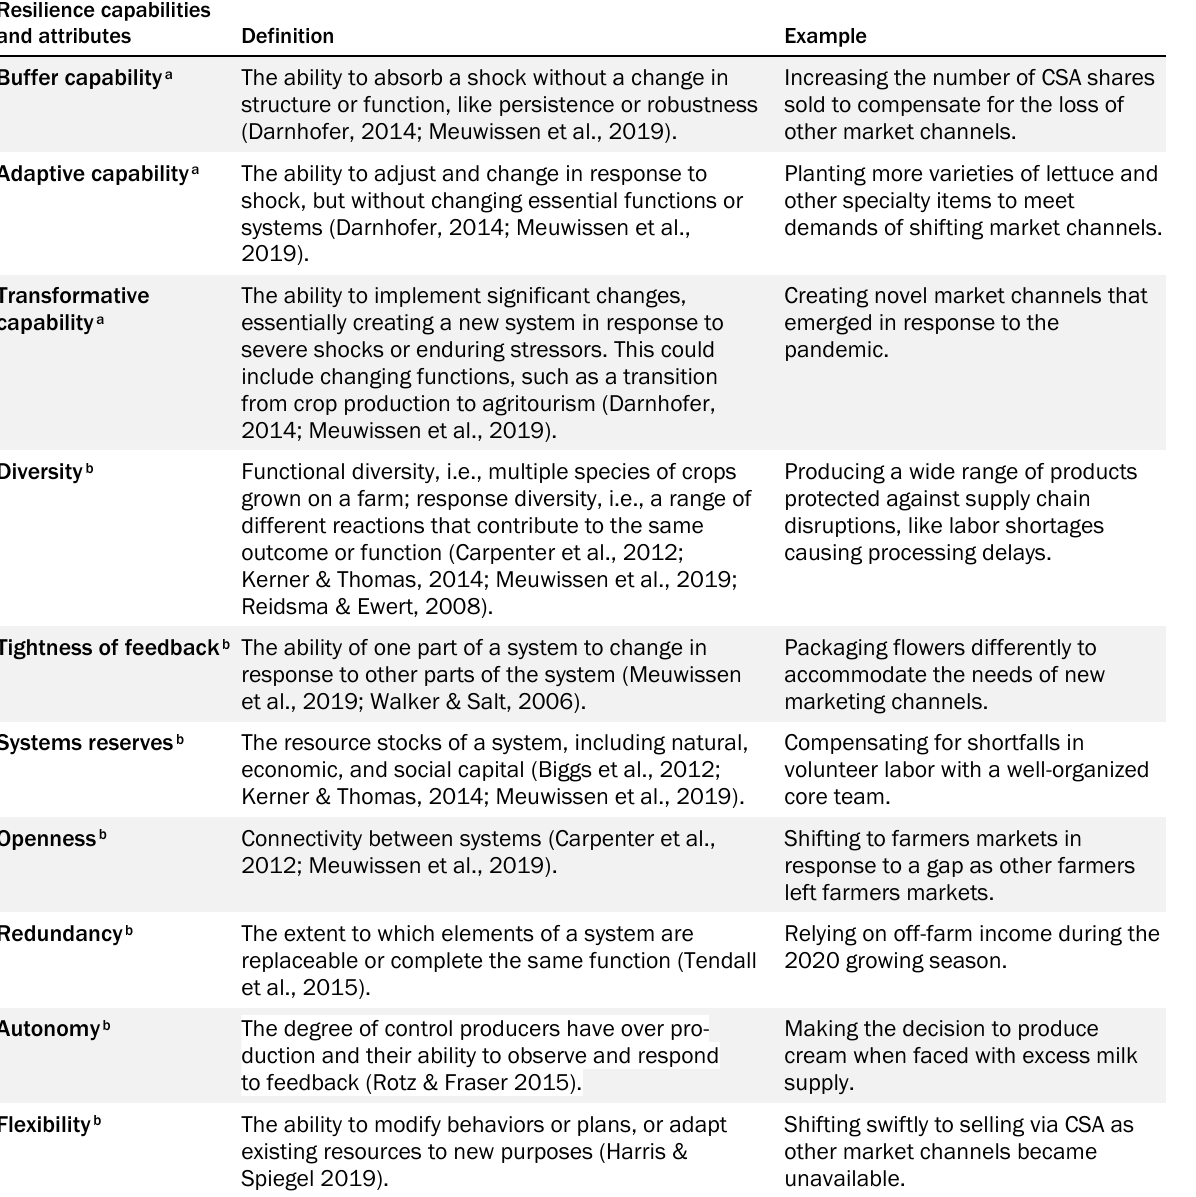
Table 3. Resilience Capabilities and Attributes with Demonstrative Examples Reported by